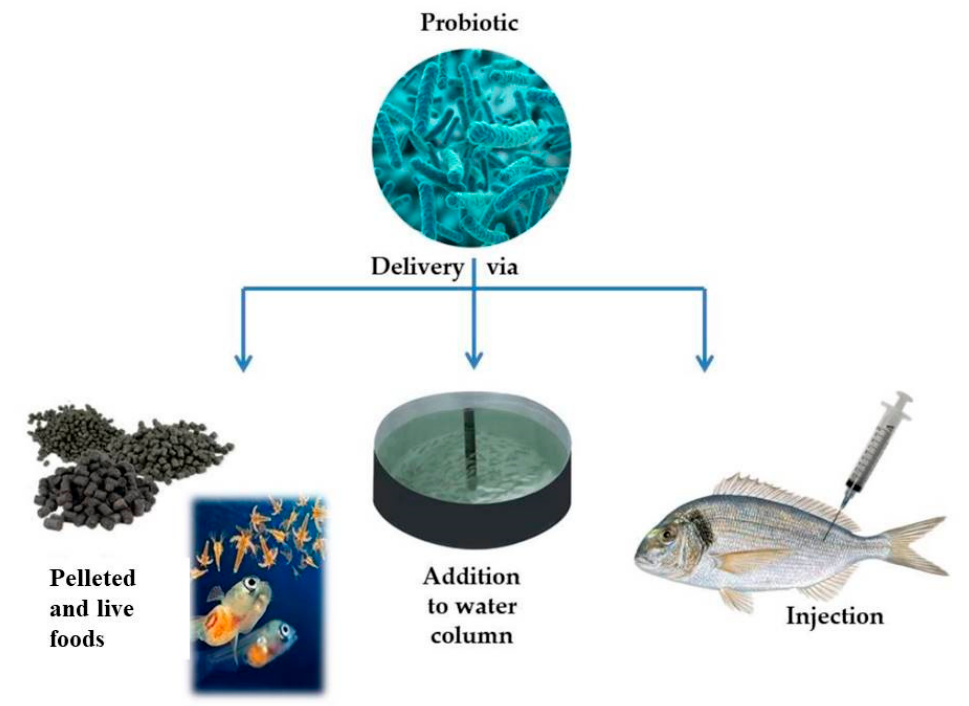
Figure 1. Di ff erent probiotic administration routes in aquaculture Figure 1. Different probiotic administration routes in aquaculture systems.